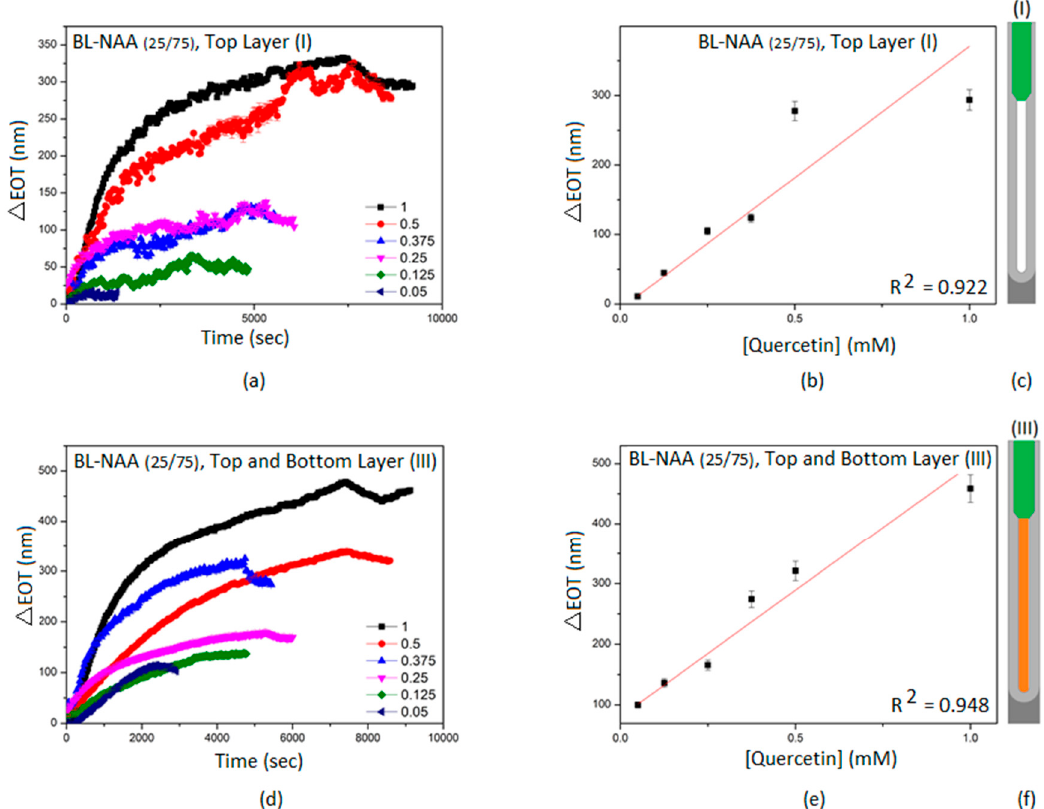
Figure 5. Time response curves showing effective optical thickness (EOT) changes and Linear fitting line for BL-NAA (25/75) (funnel structure with shorter top layer with large pore diameters and longer bottom layer with smaller pore diameters) sensing platforms measured by RIfS as a function of the quercetin concentration (0.05, 0.125, 0.25, 0.375, 0.5, and 1 mM). ( a ) Δ EOT (I) generated from the top structural layer of the BL-NAA (25/75) platform; ( b ) Linear fitting line for BL-NAA (25/75) between Δ EOT (I) and the different concentrations of quercetin (0.05, 0.125, 0.25, 0.375, 0.5, and 1 mM); ( c ) Scheme of the representative optical layer as a function of Δ EOT (I) assessment; ( d ) Δ EOT (III) generated from the top and bottom nanoporous structure of the BL-NAA (25/75) platform; ( e ) Linear fitting line for BL-NAA (25/75) between Δ EOT (III) and the different concentration of quercetin (0.05, 0.125, 0.25, 0.375, 0.5, and 1 mM). ( f ) Scheme of representative optical layer as a function of Δ EOT (III) assessment.